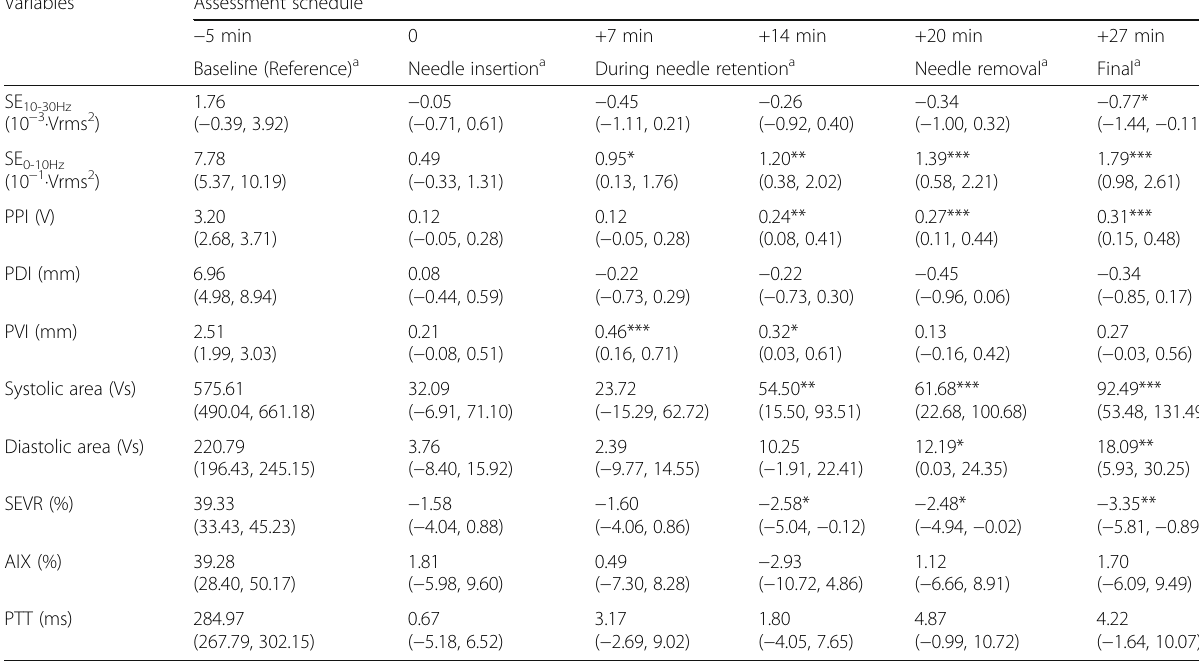
Table 3 Results of assessments on the variables related to the radial artery pressure-pulse wave